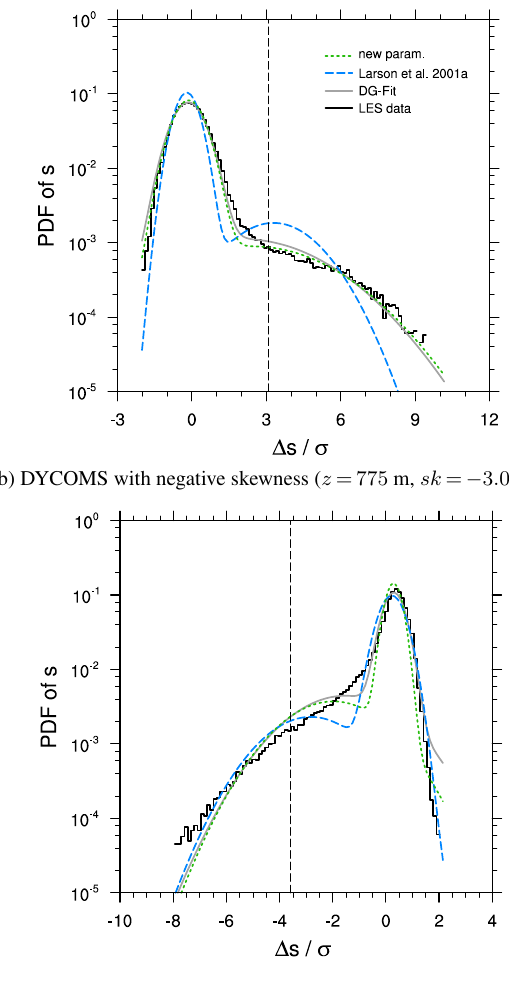
Fig. 1. PDF of s for a specific height in the cloud layer. Furthermore, the corresponding best skewness-retaining double-Gaussian fit (DG-Fit) and the resulting PDF when using the closure equations from Larson et al. (2001a) (Eq. 3) and the introduced closure equations (Eq. 4) are shown. It is ∆ s = s − s . The black, dashed line indicates the saturation value ( s =0).